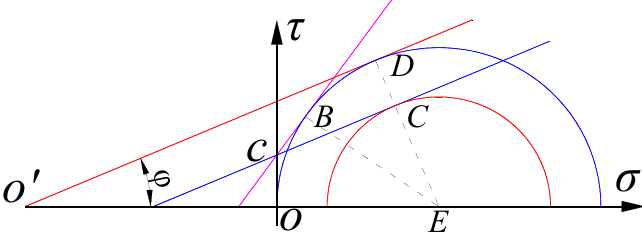
Figure 5. M-C yield strength criterion of surrounding rock.